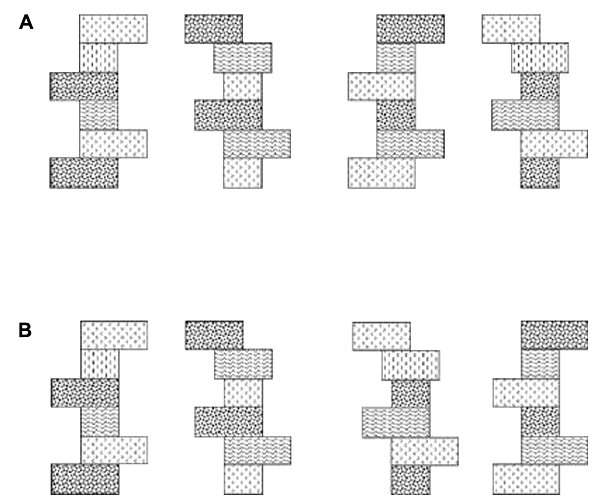
FIGURE 3 | (A) Schematic example of Shapes 1 and 2 with (left pair) original texture schemes and (right pair) the texture schemes exchanged. (B) Example ofTextures 1 and 2 with (left pair) original shapes and (right pair) the shapes exchanged. Figure adapted from Lacey etal.